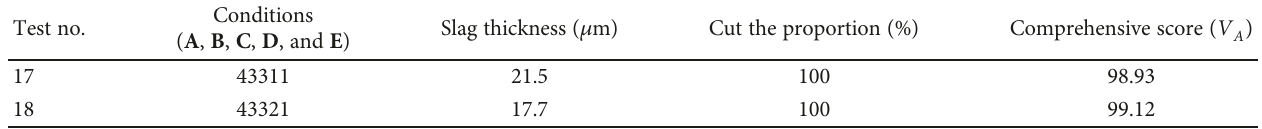
Table 7: Comprehensive evaluation table of validation experiment.